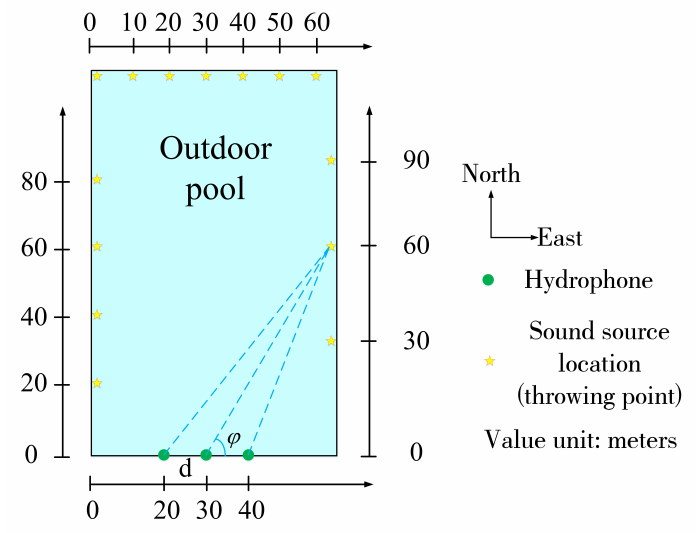
Figure 12. Schematic diagram of experimental layout.